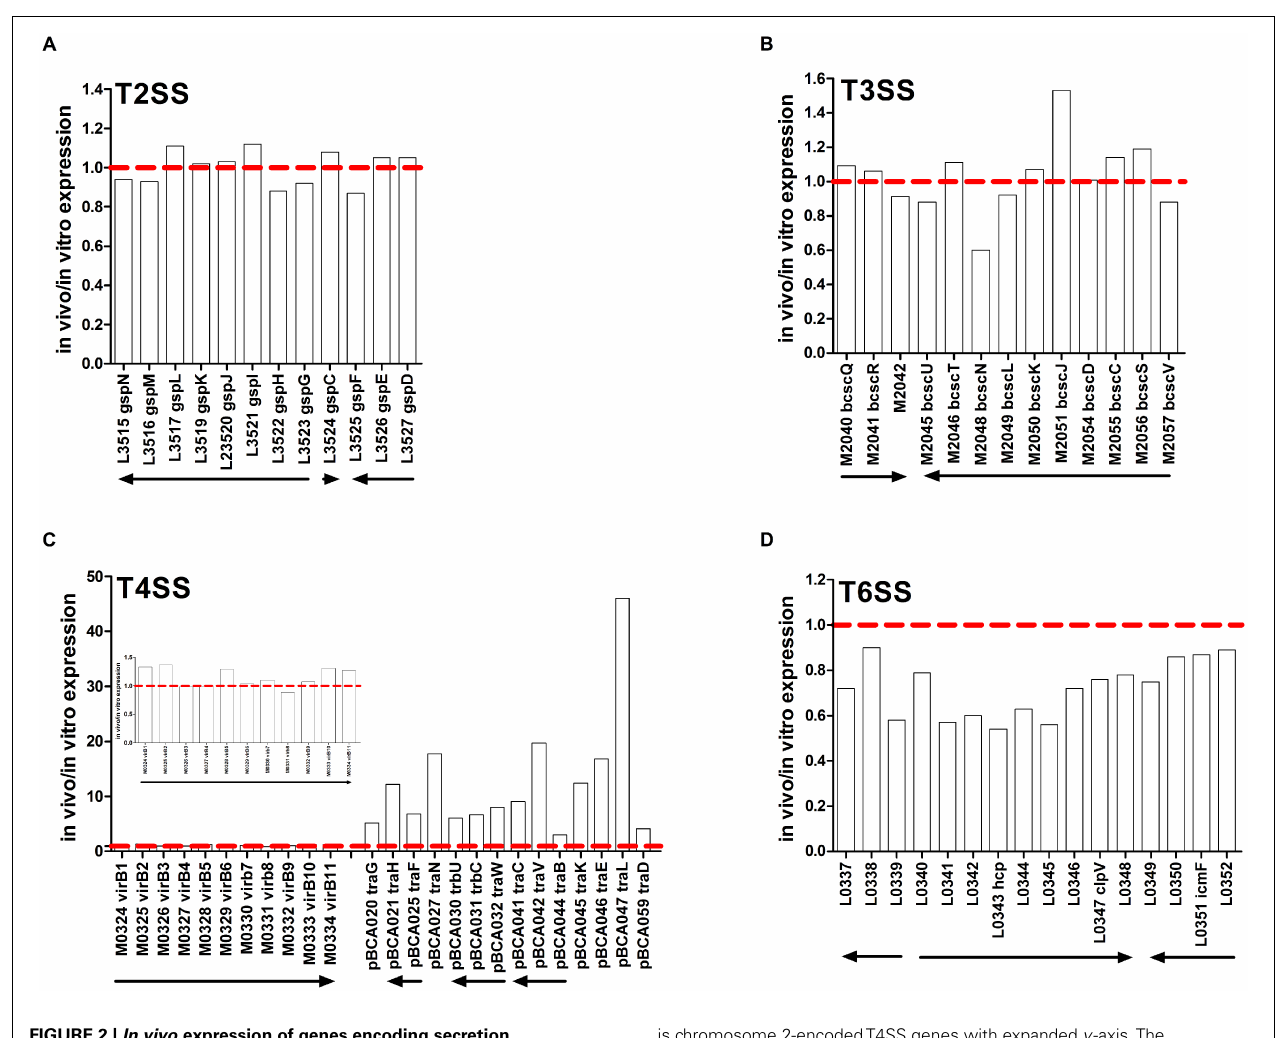
FIGURE 2 | In vivo expression of genes encoding secretion systems. Expression ratio of RNA recovered from rat lungs ( in vivo ) relative to RNA isolated from in vitro grown cultures as determined by microarray analysis. (A) T2SS, (B) T3SS, (C) T4SS, (D) T6SS. Inset in (C)